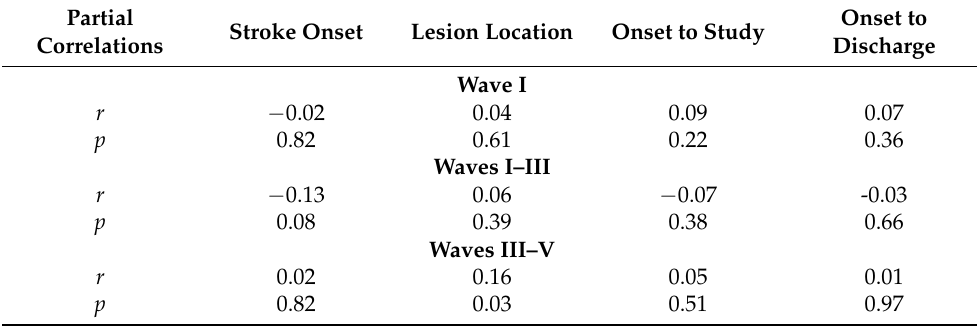
Table 2. Partial correlations between brainstem auditory evoked potential (BAEP) interpeak latencies (IPLs) and possible confounding factors.